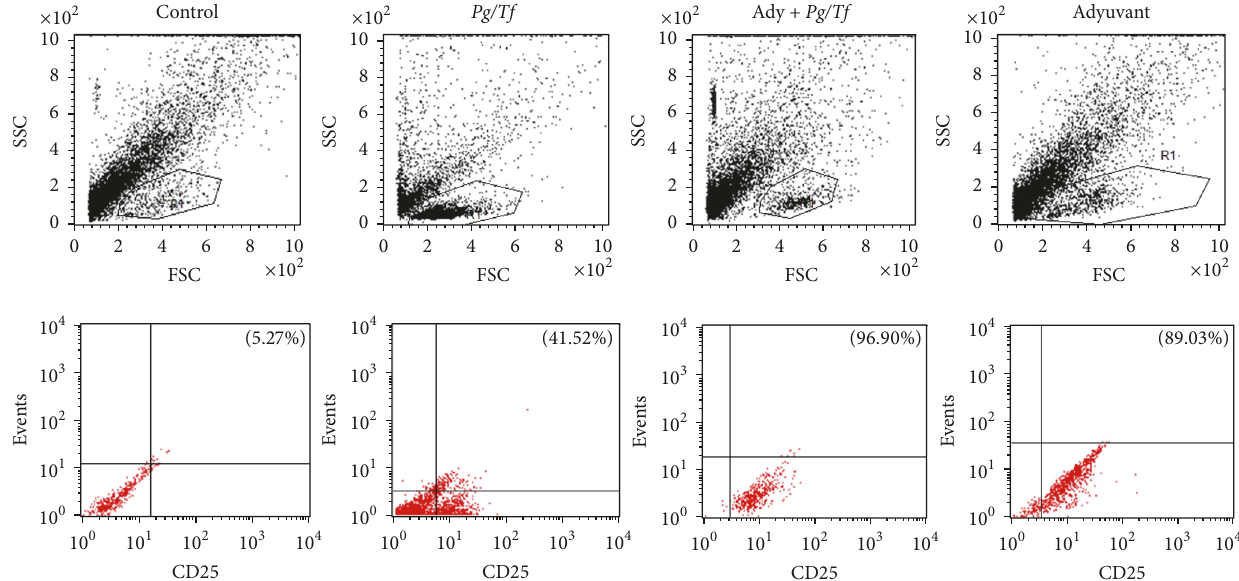
Figure 3: Flow cytometry of the frequency of regulatory T cells (CD25+) induced by Pg/Tf , CFA in BALB/c